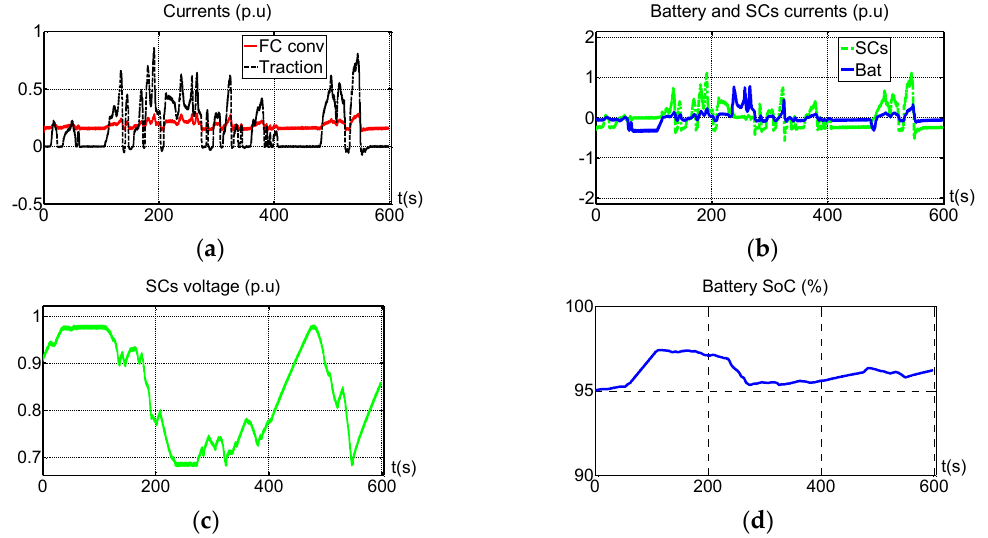
Figure 14. Experimental results: ( a ) DC–DC current of the fuel cell i dcfc (red line) and traction current i t (black line); ( b ) currents of the supercapacitors i Lsc (green line) and battery i Lb (blue line); ( c ) voltage of the supercapacitors u sc ; ( d ) state of charge of the battery SoC b.